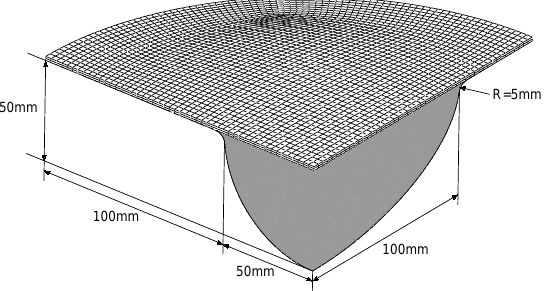
Figure 6. Finite element model of a quarter of the forming die and polycarbonate sheet.